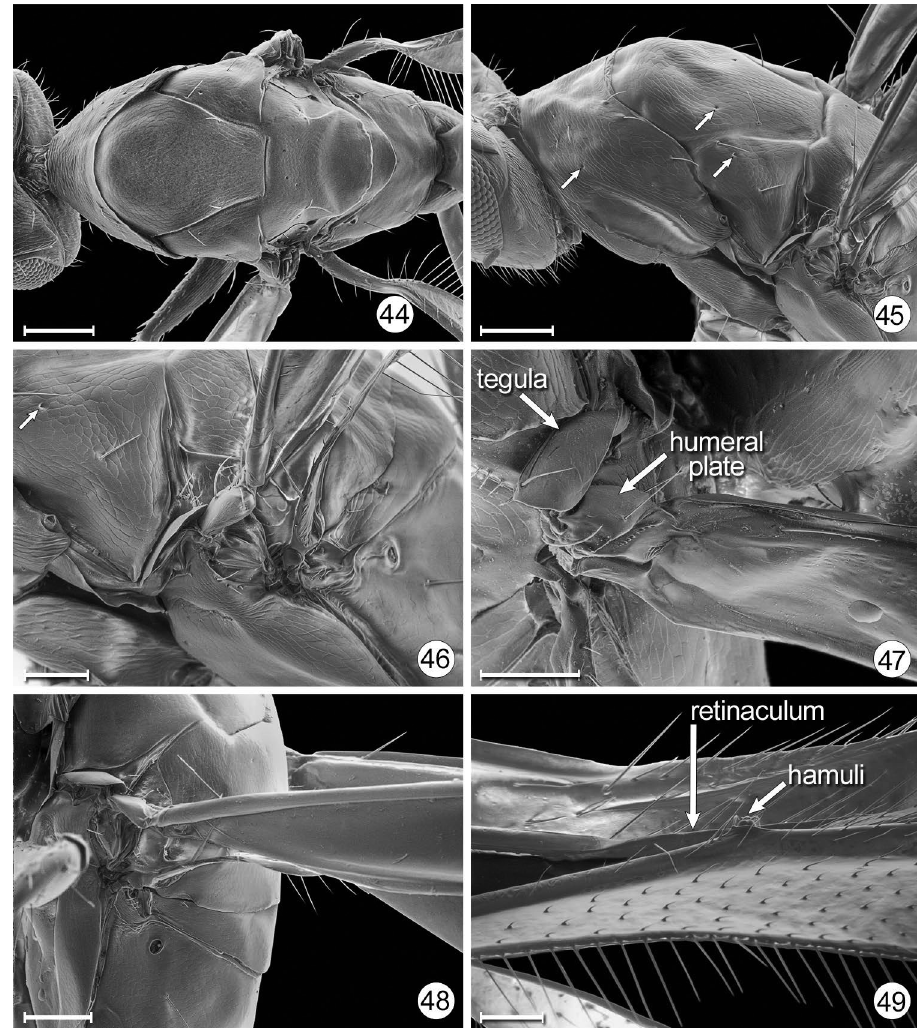
Figures 44–49. Neotriadomerus spp. 44 N. darlingi mesosoma, dorsal 45 N . sp. mesosoma, dorsolateral (arrows indicate pores) 46 N . sp. base of left wings (ventral) and surrounding mesosoma, dorsolateral 47 N. darlingi fore wing base, dorsal 48 N. longissimus fore wing base, ventral 49 N . sp., hind wing at- tachment to fore wing, ventral. Scale bar for 44, 45, 48 = 100 μm; 46, 47, 49 = 50